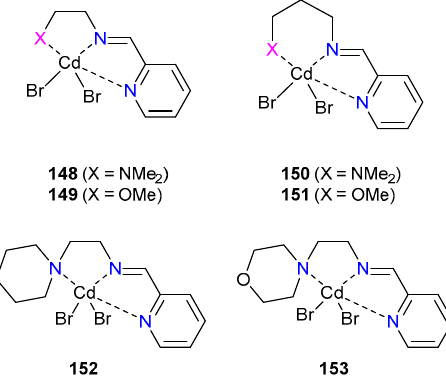
ff -base ligands